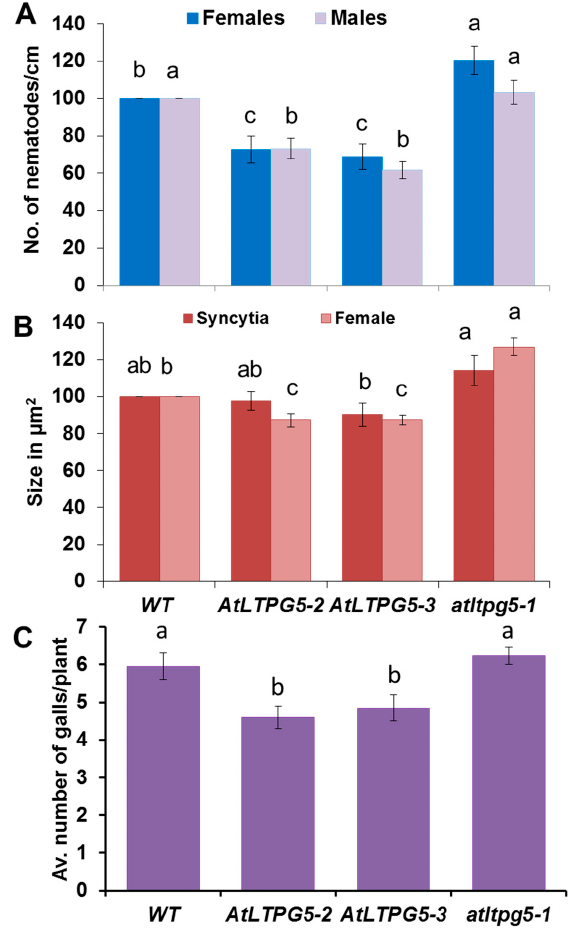
Figure 9. Nematode resistance test. The resistance of overexpression lines and a knock-out mutant of LTPg5 was compared to wild type plants after infection with nematodes. A , B : Infection with H. schachtii , A : The number of male and female nemaodes per cm of root length calculated at 15 dpi setting the wild type as 100%. The infection rate is shown in column sets with different letters indicating significant differences ( p < 0.05; ANOVA and LSD). The statistical significance was determined by three independent replicates for female and male nematodes separately. The values are means ± SE, n = 15. The bar shows standard error for the mean. B : The size of female syncytia and female nematodes at 14 dpi. Eight syncytia were selected randomly from three independent replicates (total = 24), and the size of syncytia and associated female nematodes were determined. C : M. incognita resistance test. The resistance of two overexpression lines of LTPg5 was compared to wild type plants after infection with M. incognita . The number of galls per roots were counted at 15 dpi. The number of galls given in column sets with different letters indicate significant differences ( p < 0.05; ANOVA and LSD). The statistical significance was determined by three independent replicates. Values are means ± SE, n = 12.